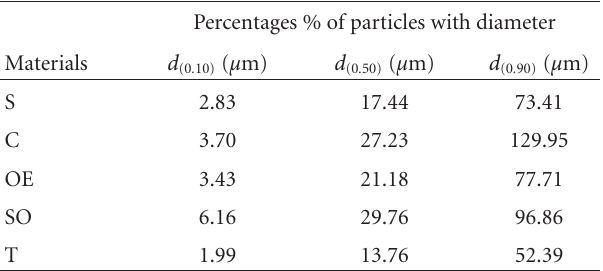
Table 4: Granulometric data for the materials used in experiments and their size